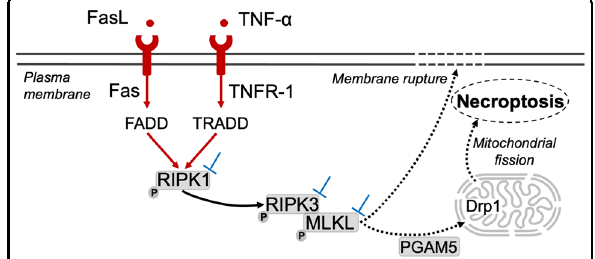
Fig. 1 Schematic overview of necroptotic cell death. Necroptosis is triggered by in fl ammatory mediators, including TNF- α and FasL. Upon the recruitment of adapter proteins, the phosphorylation of RIPK1 is induced. The necrosome is composed of interaction and activation (i.e. phosphorylation) of RIPK1, RIPK3, and MLKL. Necroptosis of the cell is induced by mitochondrial fi ssion through interaction of MLKL with mitochondrial phosphatase PGAM5 and Drp1 recruitment. Phosphorylated MLKL also triggers cell death through the disruption of the plasma membrane integrity 1,2 . Other mechanisms by which MLKL induces cell death remains to be elucidated. Pharmacological or genetic modulations ( ⊥ ) of necroptosis signaling can target RIPK1, RIPK3, MLKL, as well as their phosphorylated forms 12 – 14 . Drp1